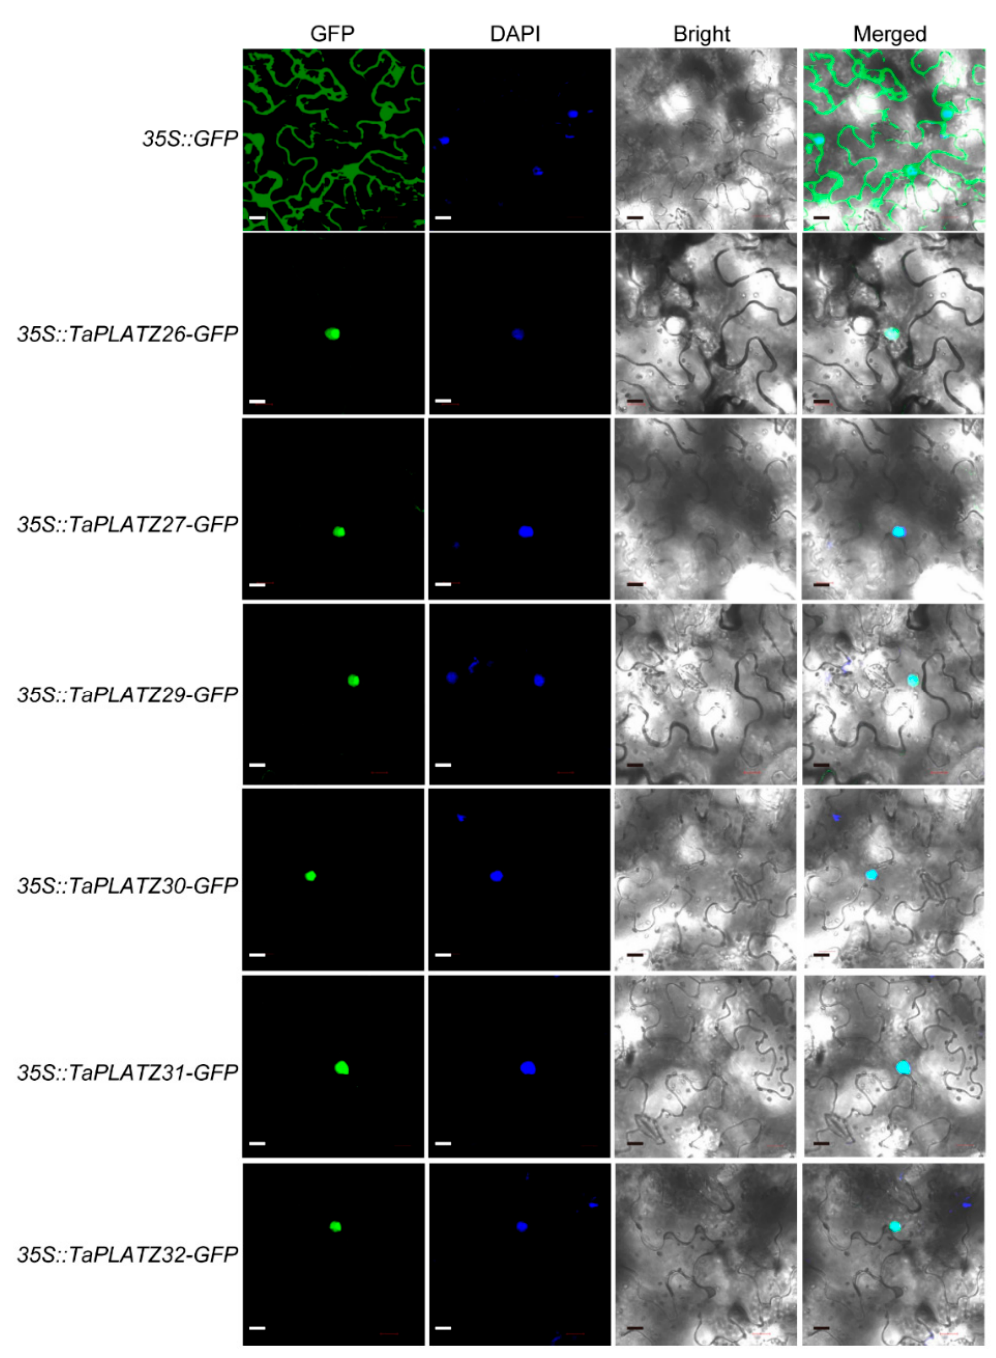
Figure 6. Subcellular localization of TaPLATZ proteins. The localization of the nucleus was detected by DAPI staining. GFP: Green fluorescence indicates the location of TaPLATZ proteins in N. benthamiana . DAPI: Blue fluorescence of DAPI indicated the location of the nucleus. Bright light: field of bright light; Merged: merge with the three former images. The scale bar = 20 μ m.